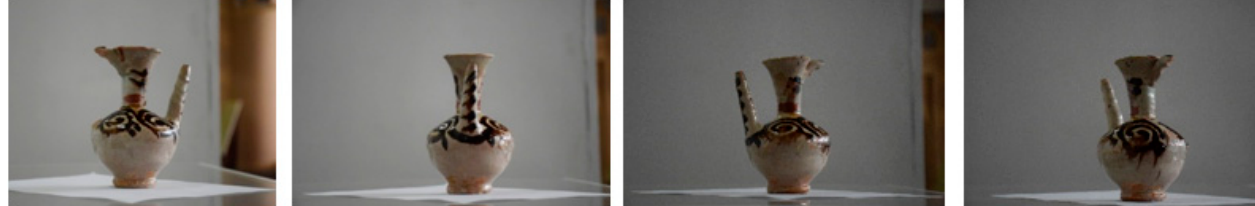
Figure 8. Sample photos of the jug without processing received from partners from Uzbekistan.